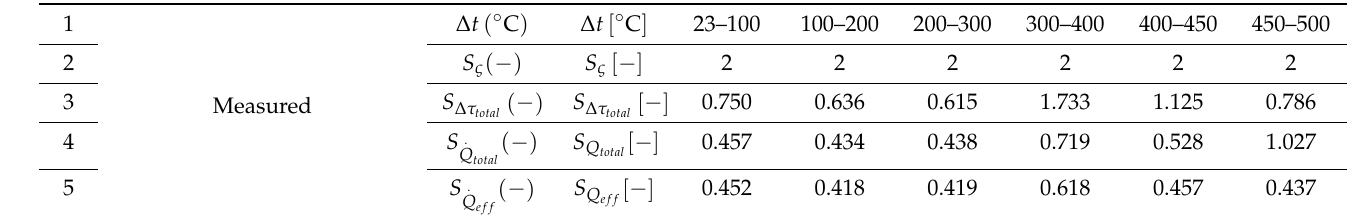
Table 6. The 1:2/1:1 Painted model/prototype; measured